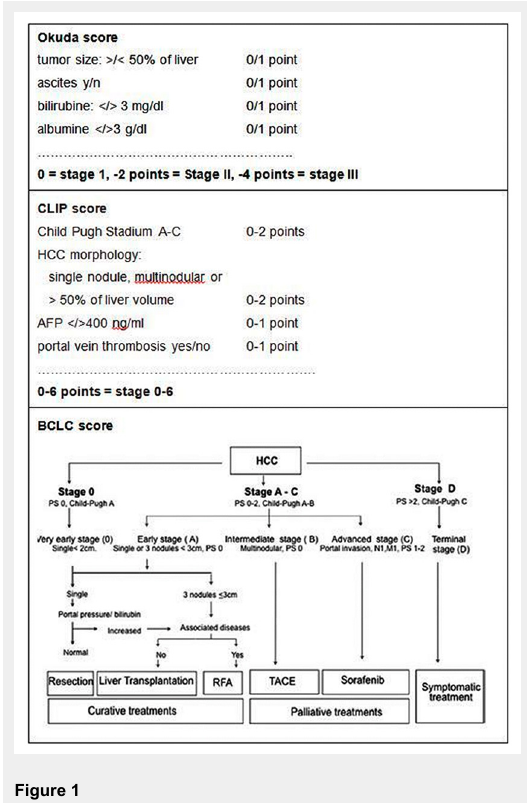
Figure 1 Principles of the Okuda, CLIP and BCLC scores as described in the literature [6, 12, 14]. AFP = alpha-foetoprotein; BCLC = Barcelona clinic liver cancer; CLIP = cancer of the liver Italian programme; RFA = radiofrequency ablation; TACE = transarterial